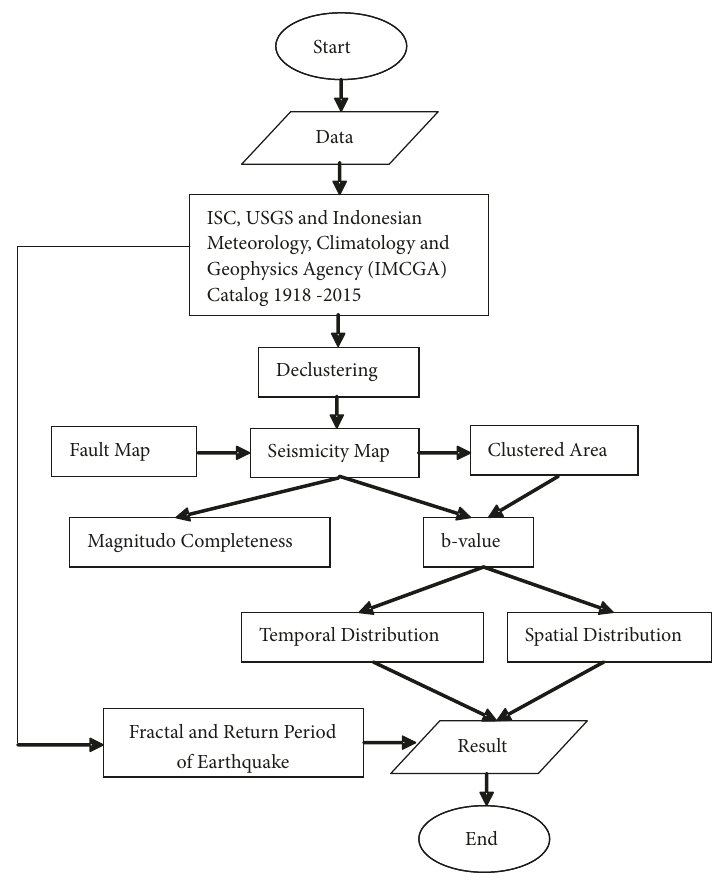
Figure 3: Flowchart of the